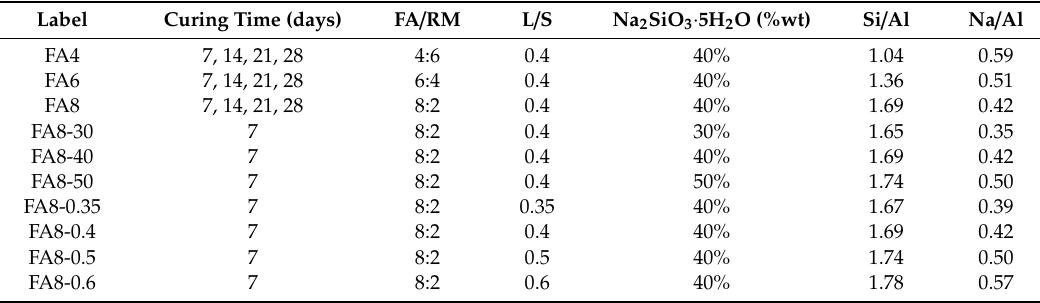
Figure 1. ( a ) Fly ash; ( b ) red mud used in the study; ( c ) prepared mixture; ( d ) cured unconfined compressive strength (UCS) specimen. Table 2. Experimental details and proportions of